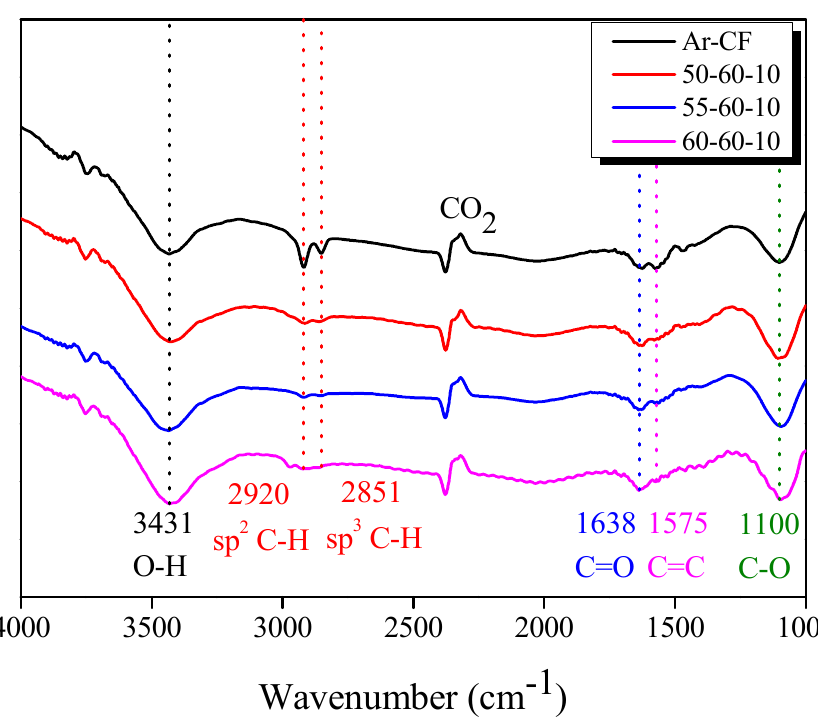
Figure 8. Fourier-transform infrared spectra of the as-received and recycled carbon fibers with varying pyrolysis conditions.